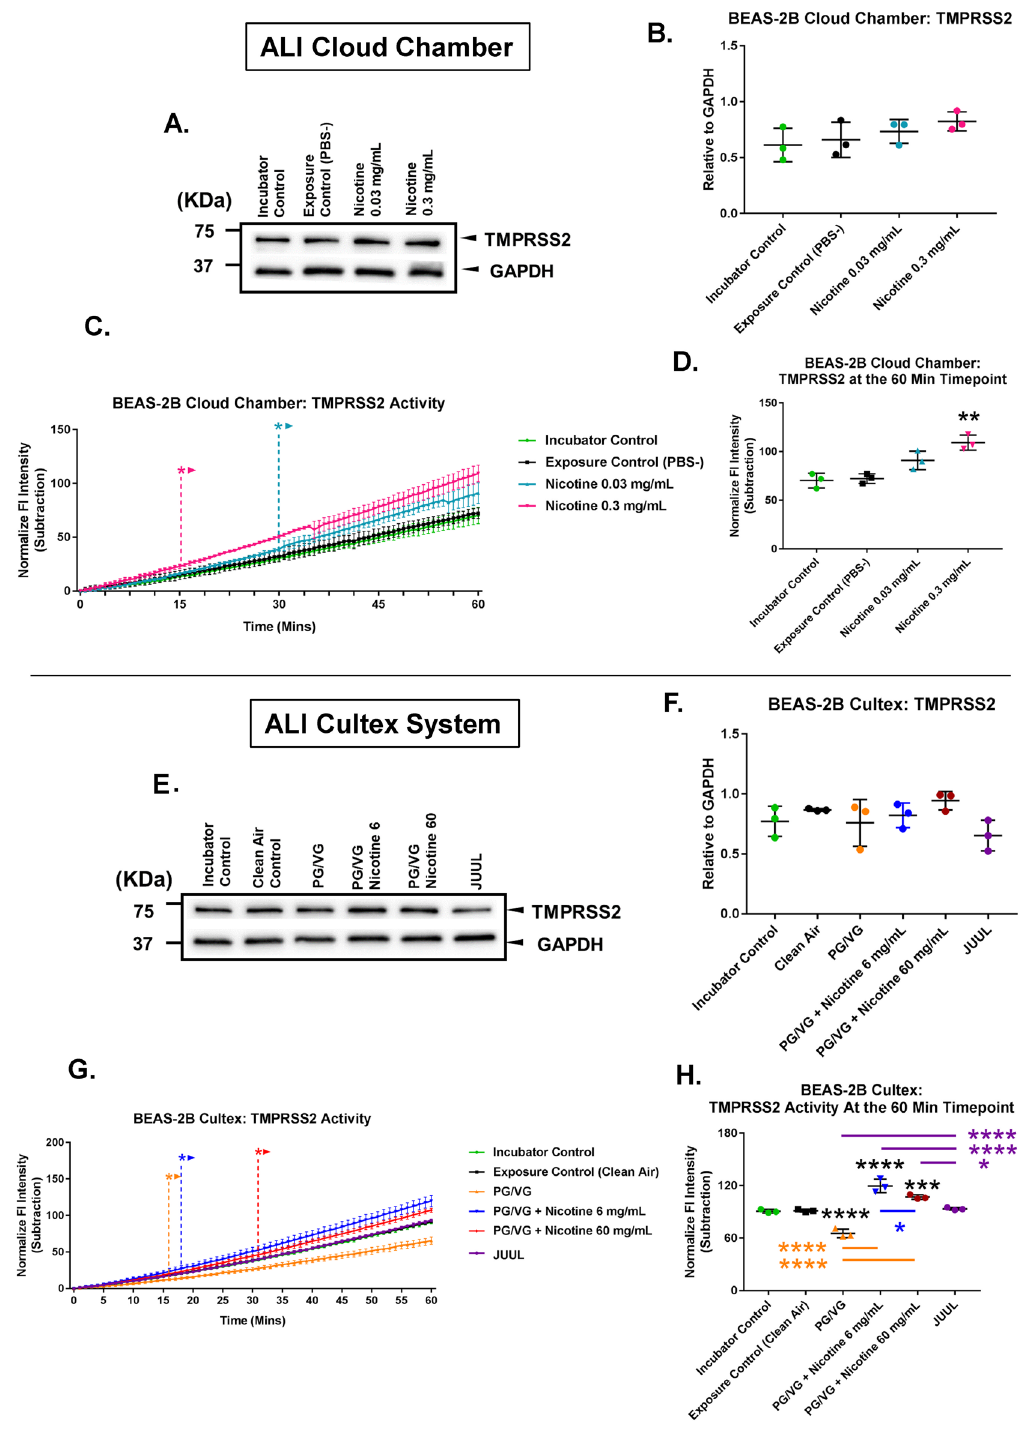
Figure 3. Effect of EC aerosols on TMPRSS2 levels and activity in BEAS-2B cells exposed at the air–liquid interface. ( A, B ) Effect of 1 puff of pure nicotine aerosol on TMPRSS2 levels; exposure was at the ALI in a cloud chamber (Western blot). ( C, D ) TMPRSS2 activity was increased by nicotine following exposure at the ALI in a cloud chamber. ( C ) Changes in activity over 60 min. * Indicate when values became significantly different than the control ( p ranged from 0.05 to 0.0001). ( D ) Activity at the 60-min timepoint. ( E, F ) Western blot showing the effect of 10 puffs of PG/VG, PG/VG/nicotine, and JUUL EC aerosol on TMPRSS2 levels during ALI exposure in the Cultex system. ( G, H ) Nicotine increased TMPRSS2 activity during ALI exposure in the Cultex system. PG/ VG decreased activity. JUUL aerosols increased activity ( G ) Changes in activity over 60 min. * Indicate when values became significantly different than the control ( p ranged from 0.05 to 0.0001). ( H ) Activity at the 60-min timepoint. All graphs are plotted as means ± standard deviation of three independent experiments. Following a Box-Cox transformation, B, D, F and H were analyzed using a one-way ANOVA followed by Tukey’s test to compare means. Black * = significantly different than the control. Colored * and colored lines = significantly different groups. ( C ) and ( G ) were analyzed using a two-way ANOVA followed by Dunnett’s test to compare means to the control. * p < 0.05, ** p < 0.01, *** p < 0.001, **** p < 0.0001. Western blots were horizontally cropped from the original